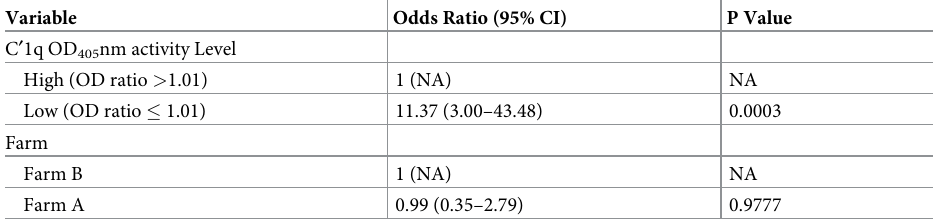
Table 3. Odds ratios for the outcome of pneumonia associated with C ՛ 1q activity-level and farm.